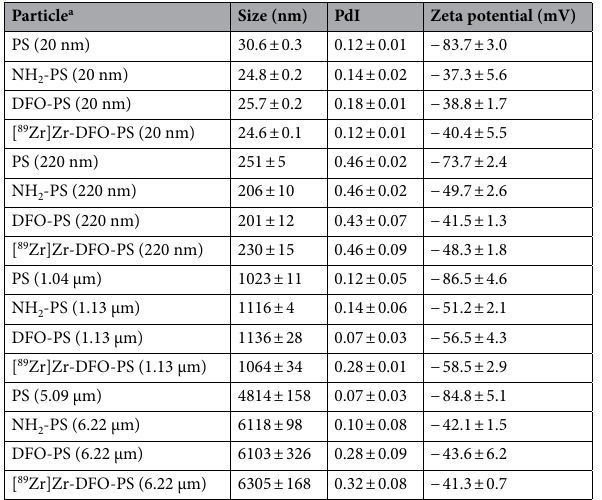
Table 1. Size, polydispersity index (PdI), and zeta potential measurements of the unmodified PS, NH 2 -PS, DFO-PS, and [ 89 Zr]Zr-DFO-PS particles. a The size in parentheses is the size reported by the